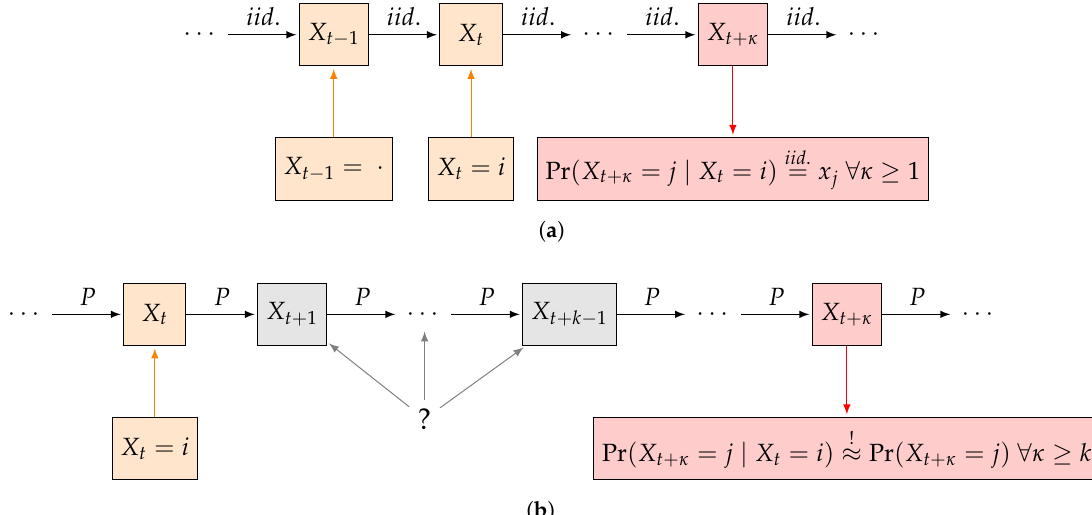
Figure 1. Comparison of switching cost optimization in [1] to our approach. ( a ) Model in [1] assumes independent choice of next pure-strategy; ( b ) Our model allows for first-order dependence when choosing next pure-strategy but controls the deviation from the independence assumption after k or more subsequent